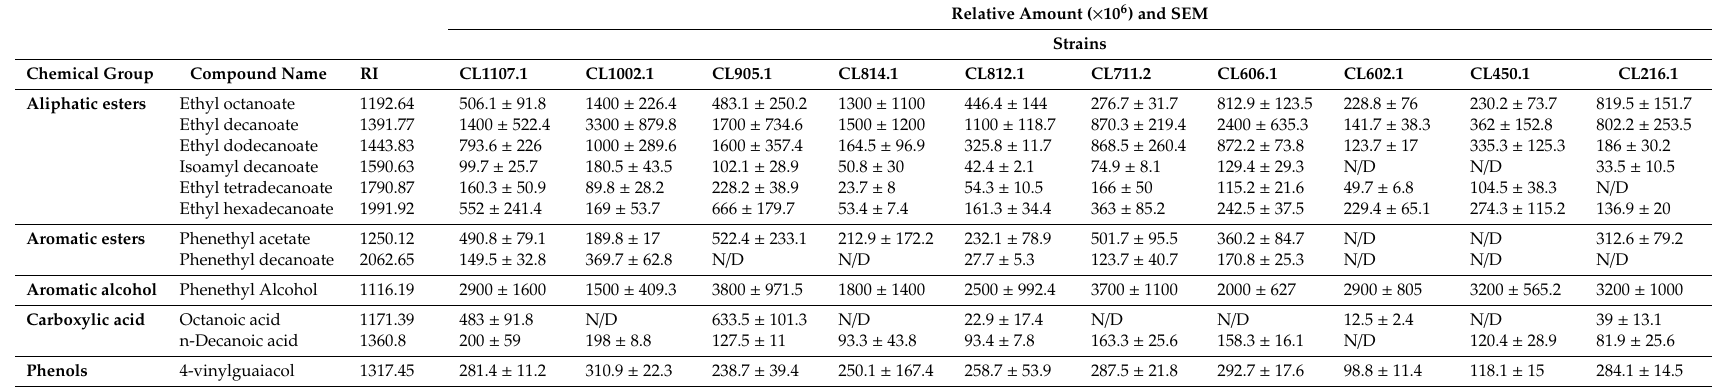
Table 1. Main Volatile Compounds detected in S. eubayanus